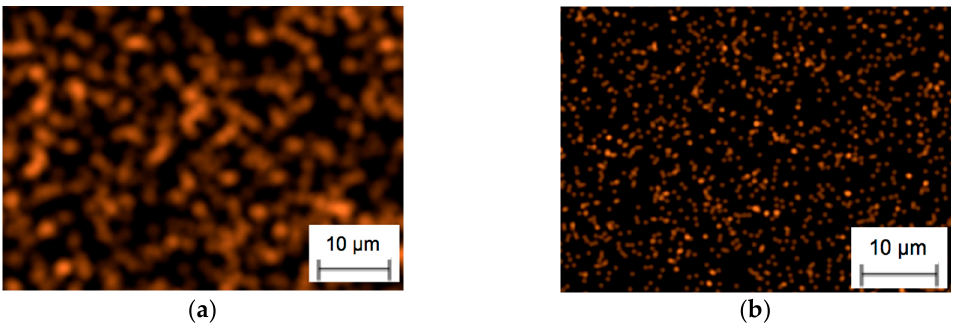
Figure 4. Yttrium ( a ) and rhenium ( b ) distribution on the nitride ceramic surface after ion implantation.